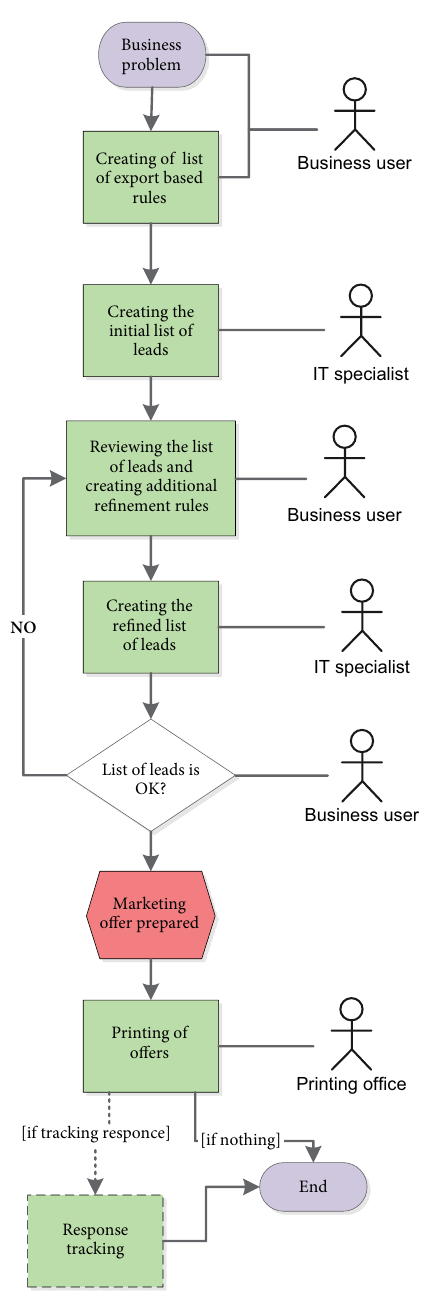
Fig. 2. Process model “BEFORE data mining implementation”